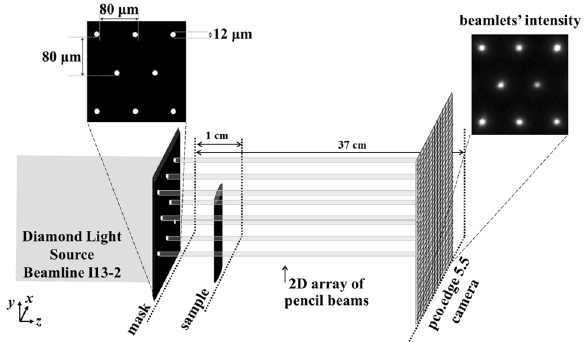
Figure 1. Schematic (not to scale) of the experimental